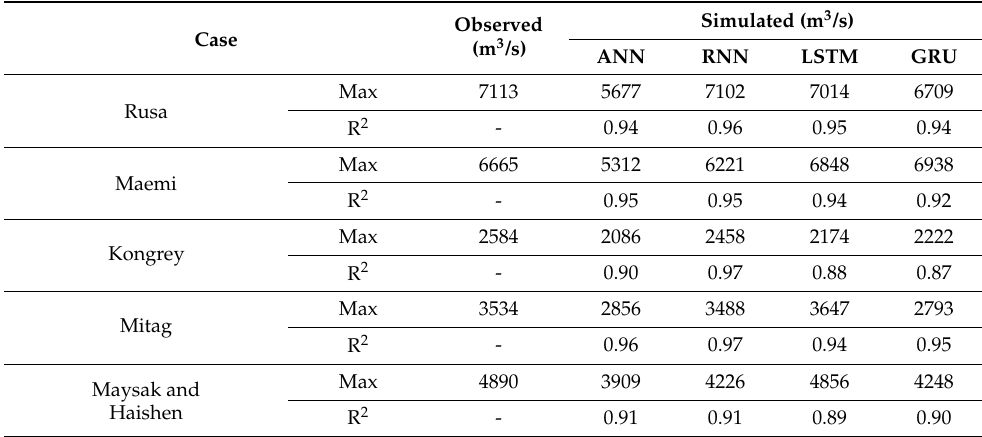
Table 11. Predicted inflow to Imha Dam by typhoon